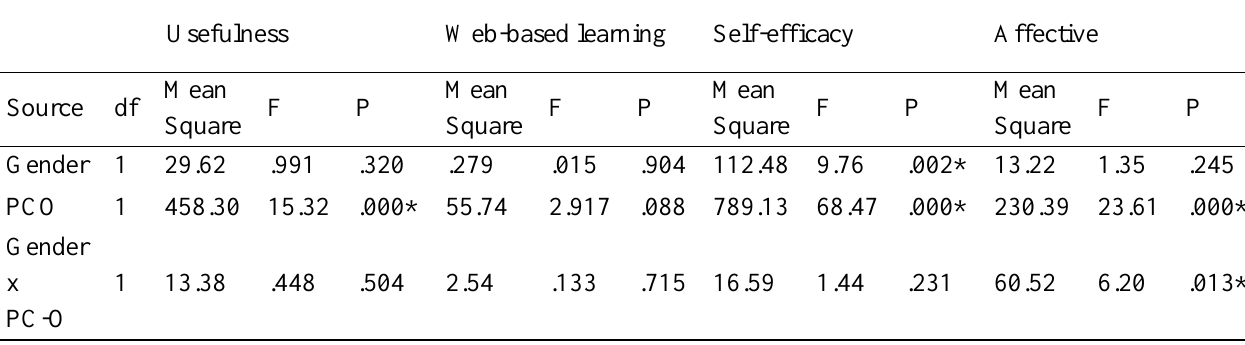
The Two-Way ANOVA Results on the Web Attitude Depending on Gender and PC Ownership Usefulness Web-based learning Self-efficacy